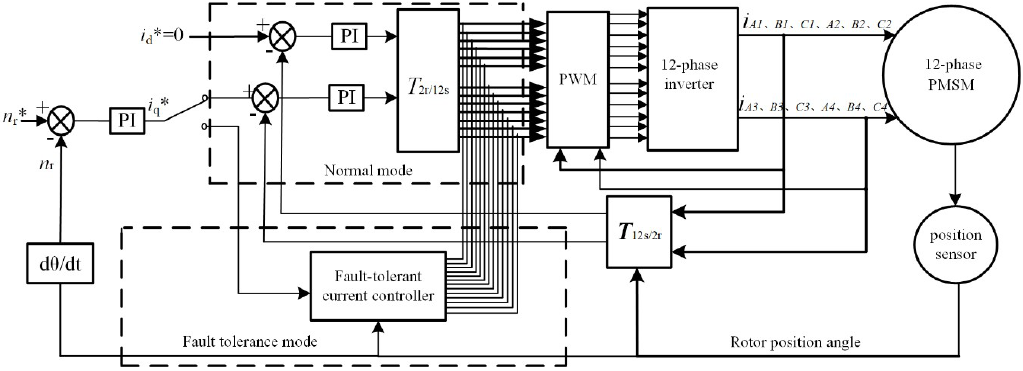
Figure 2. Diagram of 12-phase PMSM with fault-tolerant ability.